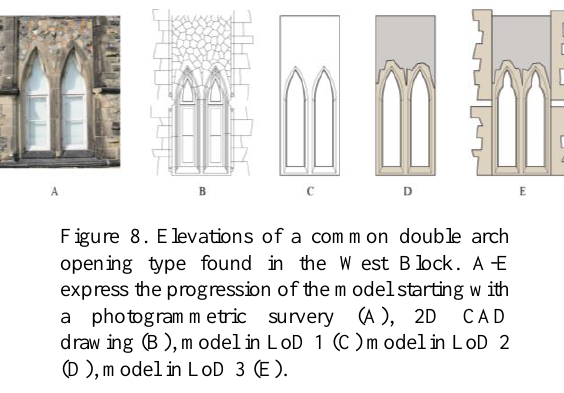
Figure 8. Elevations of a common double arch opening type found in the West Block. A-E express the progression of the model starting with a photogrammetric survery (A), 2D CAD drawing (B), model in LoD 1 (C) model in LoD 2 (D), model in LoD 3 (E). Insertion of the CAD tracings of the